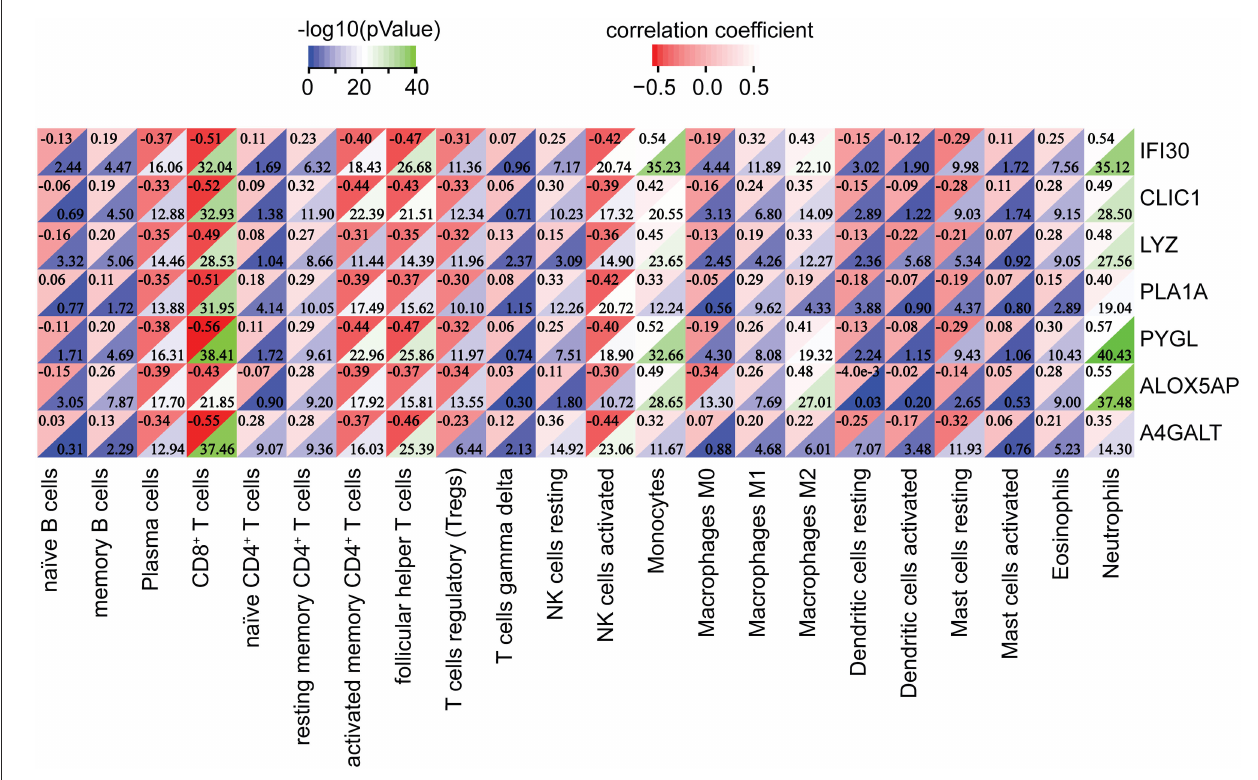
FIGURE9 Correlation between the hub genes and immune infiltrating cells. ** p < 0.01, *** p <